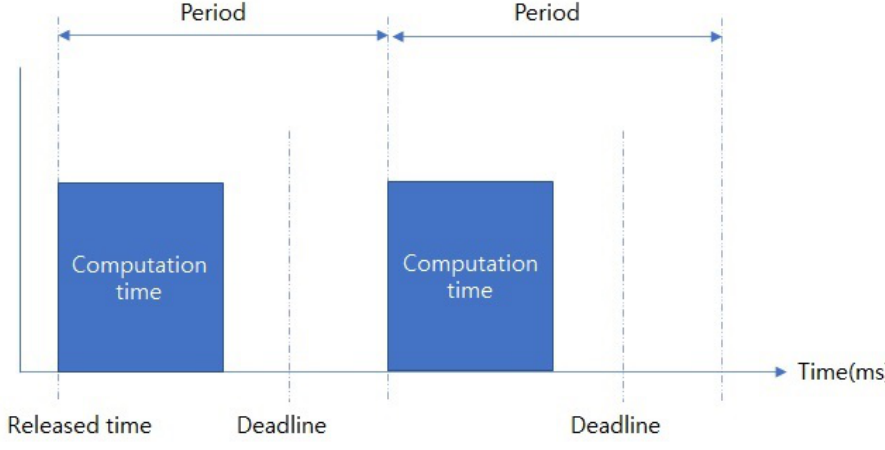
Figure 3. Message characteristic for factory